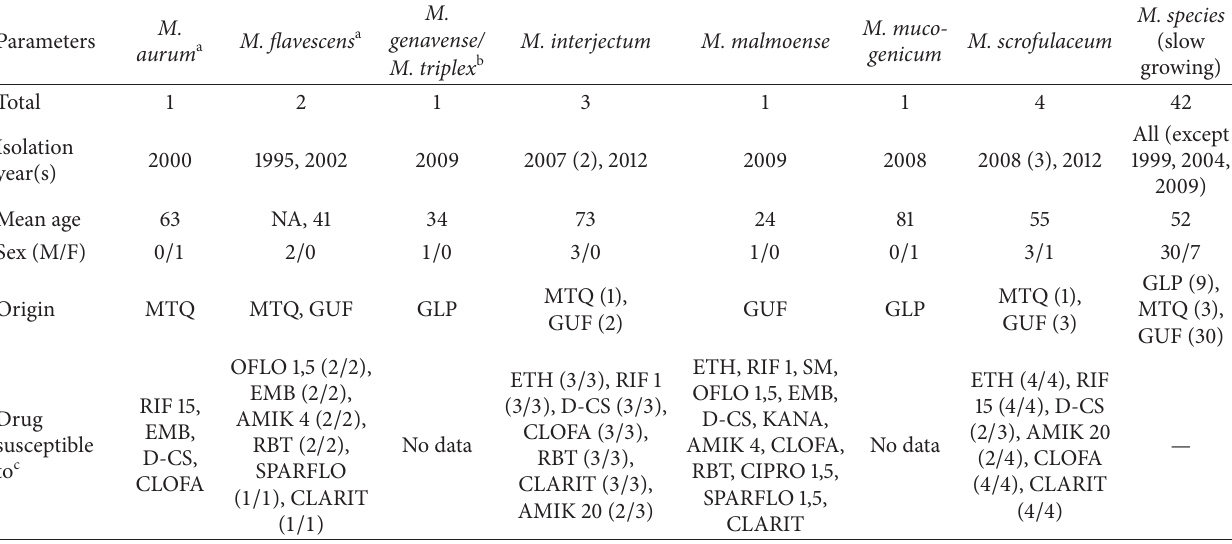
Table 3: Isolation patterns of rarely isolated NTM